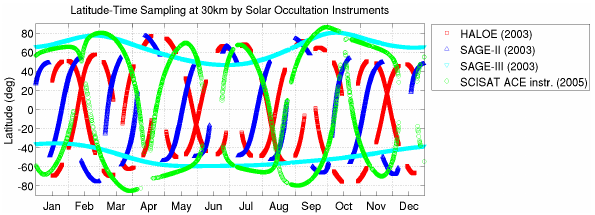
Figure 4. Latitudinal coverage for the solar-occultation instruments (example years: 2003 and 2005). SAGE I is similar to SAGE II (blue triangles), POAM and ILAS instruments are similar to SAGE III (turquoise